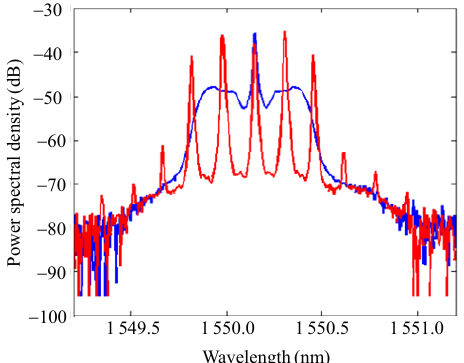
Fig. 15 Output spectra with an input power of 400 mW (blue: without seed; red: with seed).